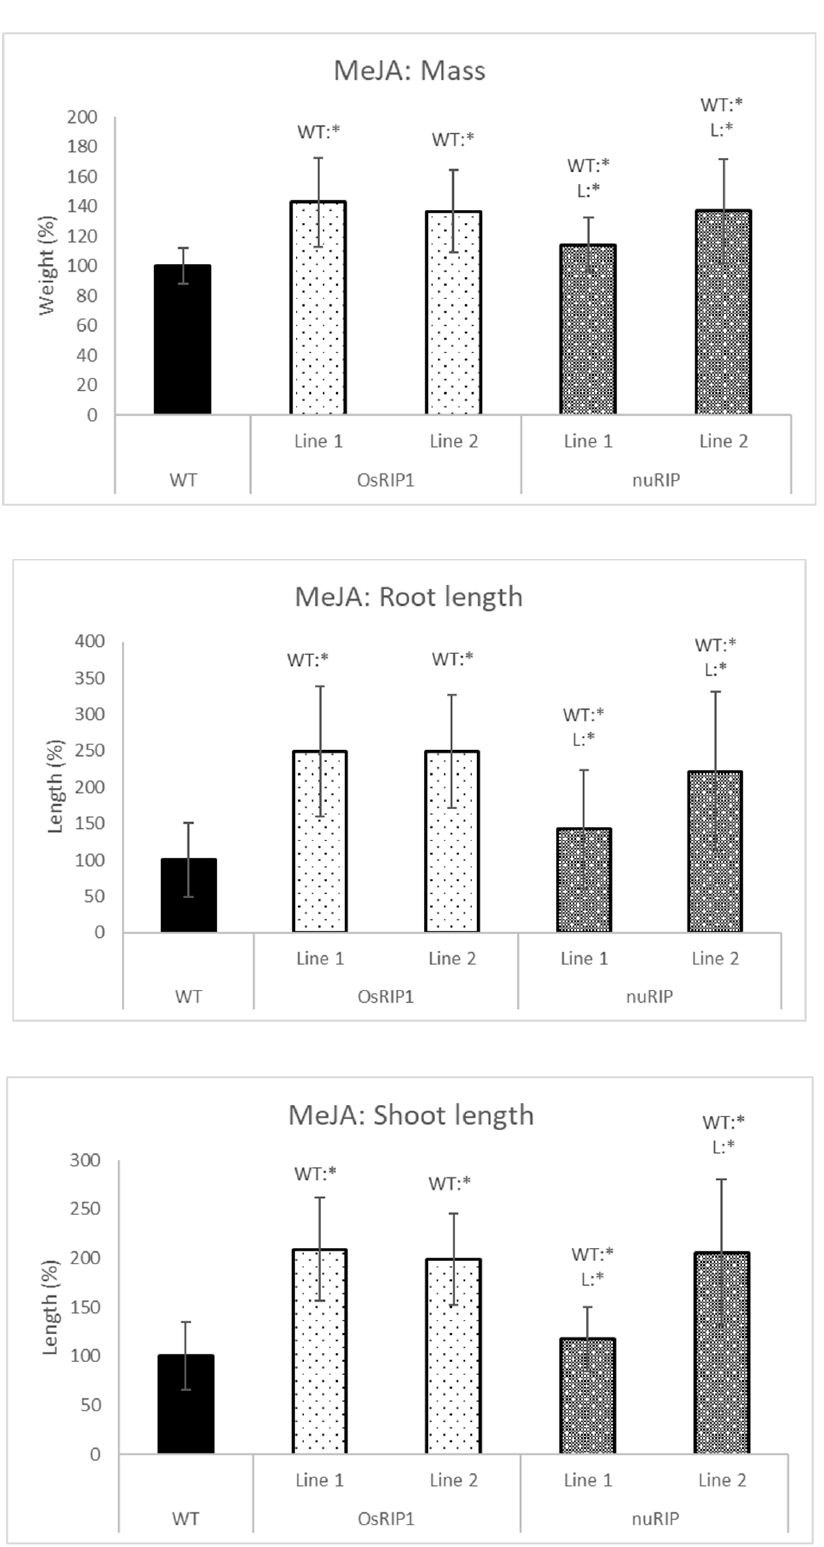
Figure 8. Total mass, shoot and root length of one-week-old plants from different transgenic lines subjected to 5 µM methyl jasmonate (MeJA) compared to those of wild-type. WT:* refers to a significant difference to wild-type plants. L:* indicates a significant difference to the other transgenic line of the same construct. The histogram is based on averages; error bars represent the standard deviation. Each data point is gathered from 50 plants per line.